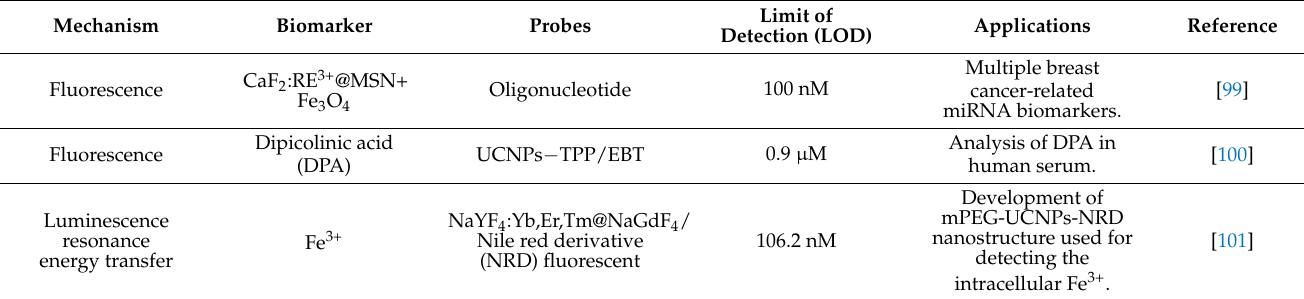
Figure 7. Mechanism of FRET resulting in fluorescence. Table 3. UCNPs used in